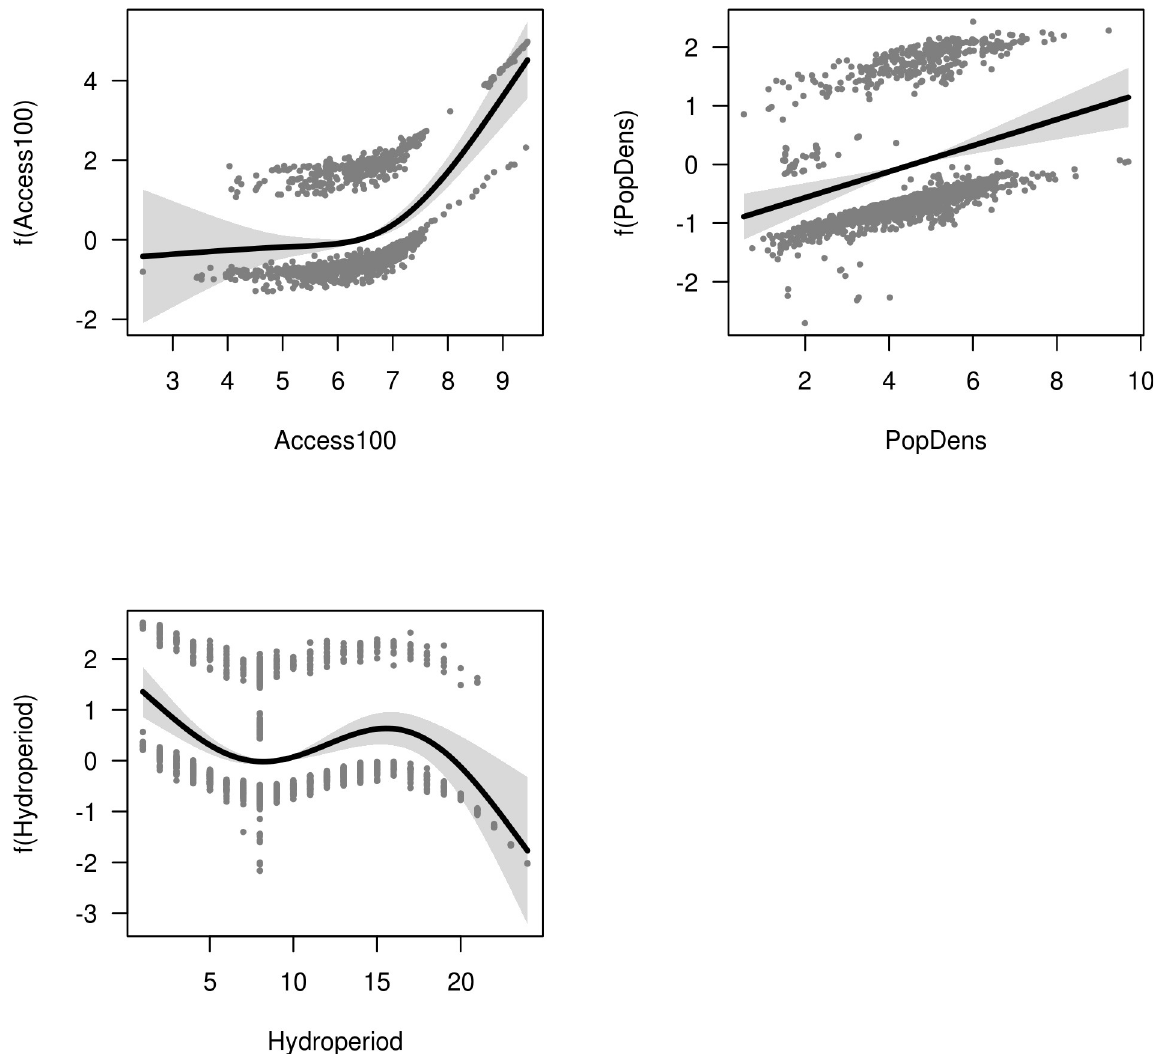
Fig 3. Response of vegetation cover in the middle basin. Response of vegetation cover in the middle basin to each term in a GAM model including local relative accessibility (Access100), population density (PopDens), and hydroperiod. The response is on the scale of the link function. Bands show two standard errors around the